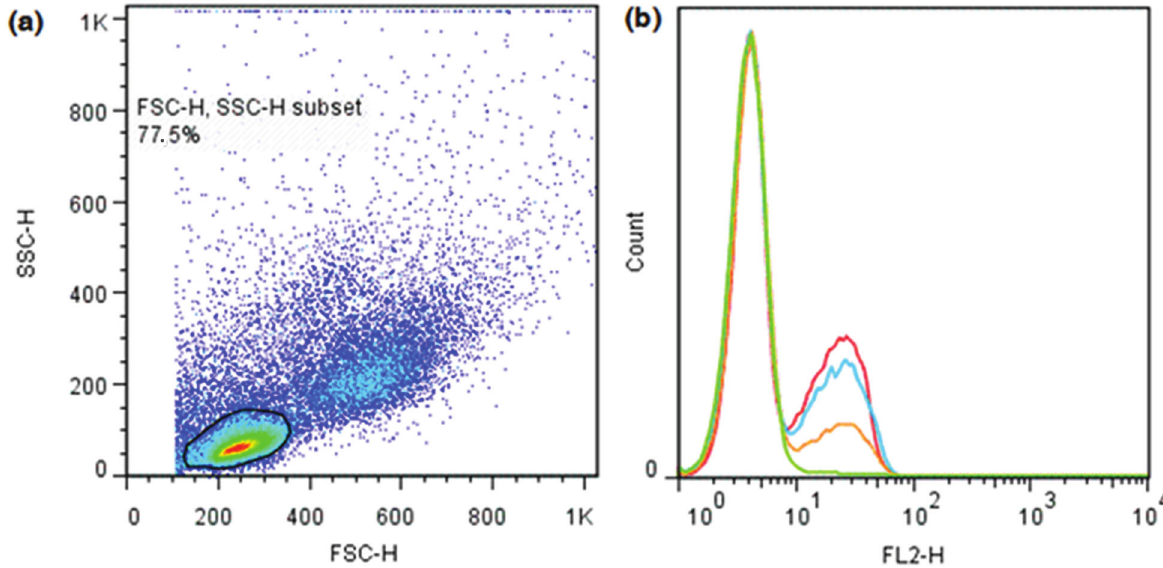
Figure 1 - ( a ) FSC/SSC 2D-density plot, with gate drawn around the lymphocyte population ( b ) FL2 histogram corresponding to active caspase-3 expression from gated lymphocytes, gathering data of non-irradiated (green), 1 Gy- (orange), 2 Gy- (blue) and 4 Gy-irradiated samples (red). The first peak (lower 10 1 ) represents cells negative for active caspase-3 expression, and the second peak (higher 10 1 ), those positive to this parameter. The second peak height indicates positivity intensity, in a way that non-irradiated lymphocytes (green) were primarily negative for the presence of active caspase-3, whereas irradiated lymphocytes were positive for active caspase-3 staining, increasing for higher doses.